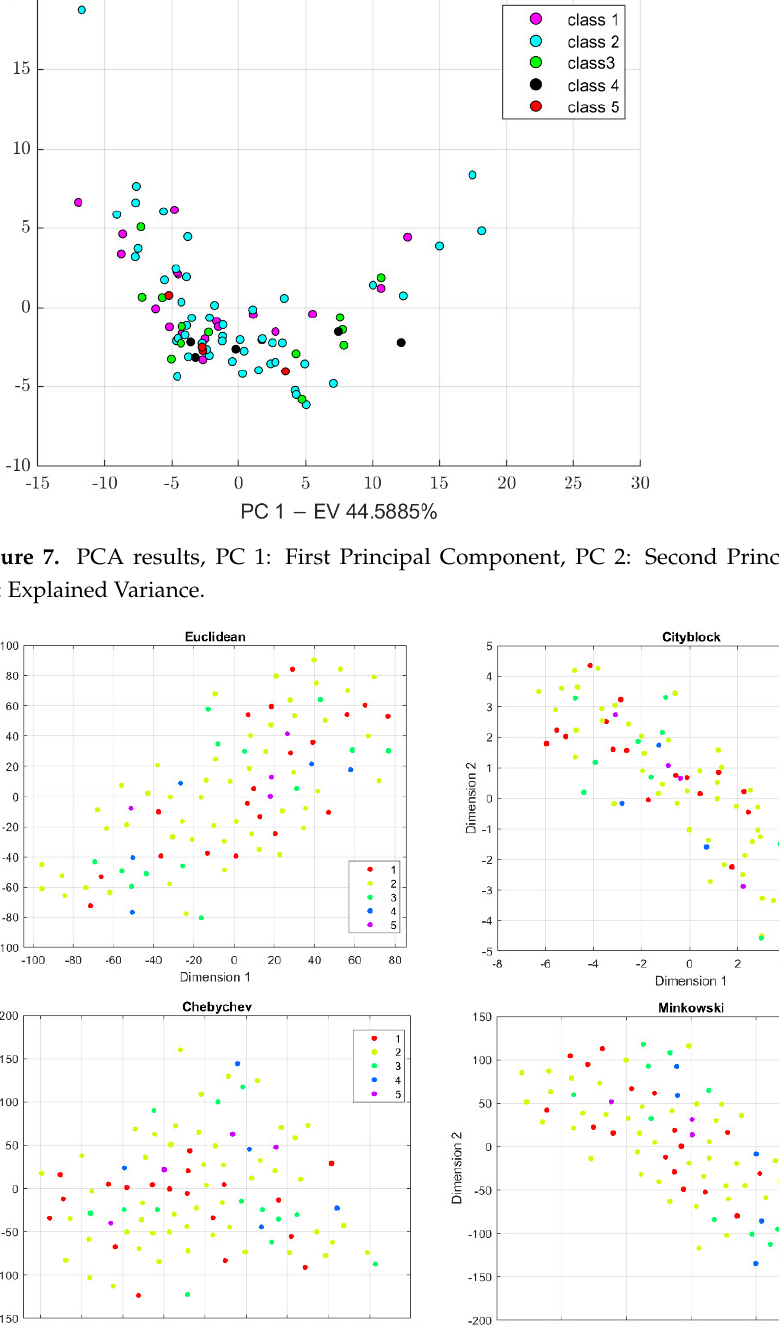
Figure 9. Kruskal-Wallis Table for the PC 1 scores. p -value = 0.6268 > 0.05. Figure 10. Kruskal-Wallis Table for the PC 2 scores. p -value = 0.1049 > 0.05. Figure 11. Box plots for the PC1 and PC2 scores.